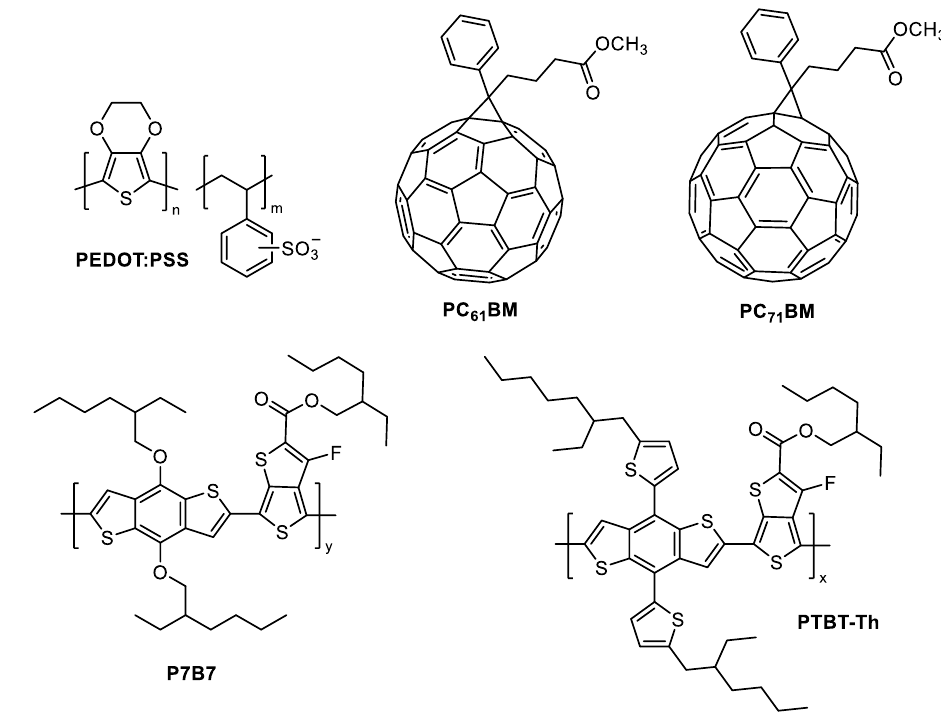
Figure 5. Chemical structures of other mentioned